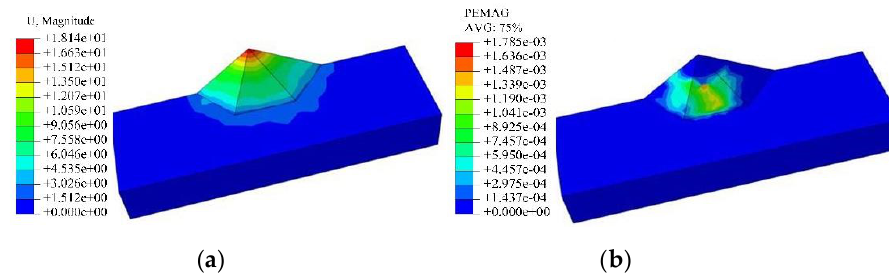
Figure 19. The displacement cloud map and plastic zone cloud map of ridge slope after excavation. ( a ) Displacement cloud map; ( b ) plastic zone cloud map.